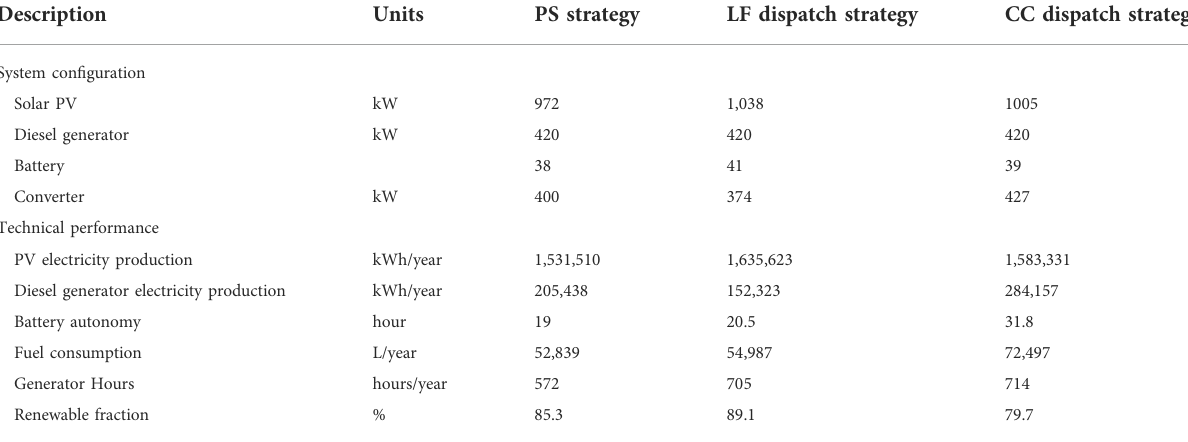
TABLE 7 Technical performance under different control